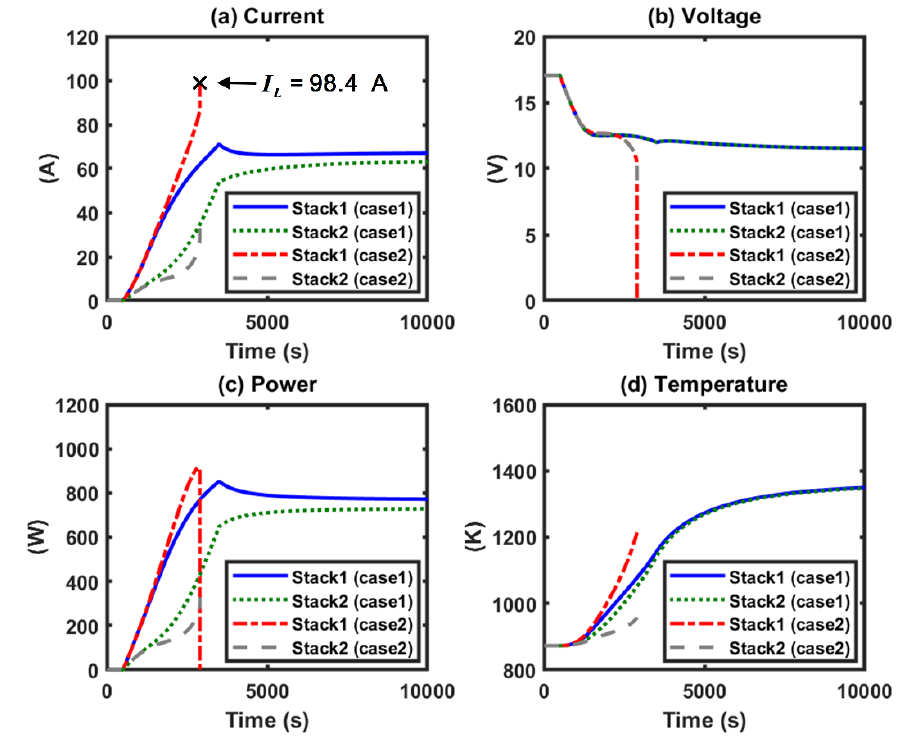
Figure 7. Transient response of the FC system obtained when the two employed FC stacks have different ohmic properties. Case 1 includes the heat exchange between stacks, whereas case 2 excludes it. ( a ) Stack output current, ( b ) stack voltage, ( c ) stack output power, and ( d ) stack temperature. The system encounters a thermal runaway when there is no heat exchange between stacks.